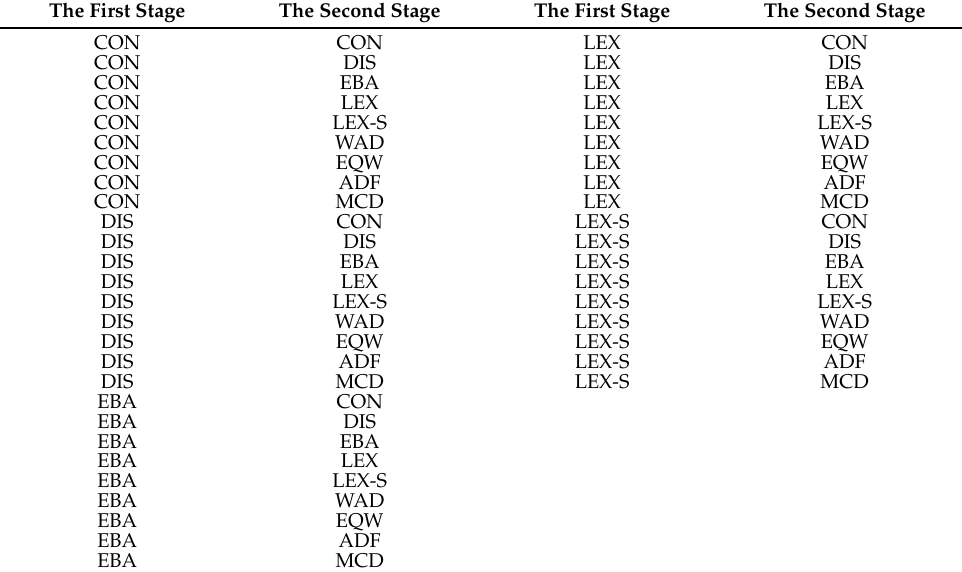
Table A2. Two-stage decision strategies used in the